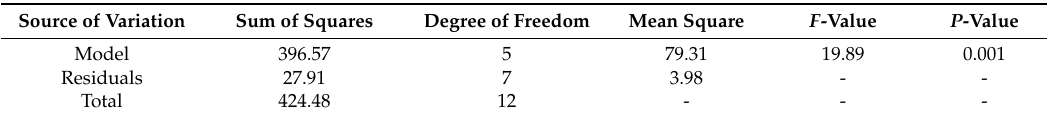
Figure 6. Residuals of photocatalytic MG decolorization after 30 min in each experiment by plasma-treated catalysts. Table 3. Analysis of variances for photocatalytic MG decolorization using plasma-treated immobilized TiO 2 photocatalyst.